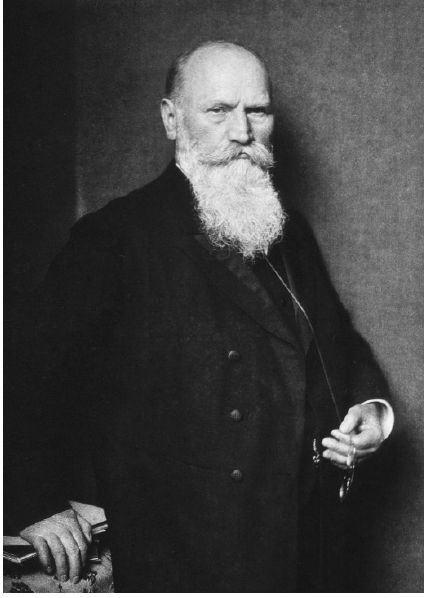
Figure 1. Heinrich Wilhelm Gottfried von Waldeyer-Hartz (1836–1921).